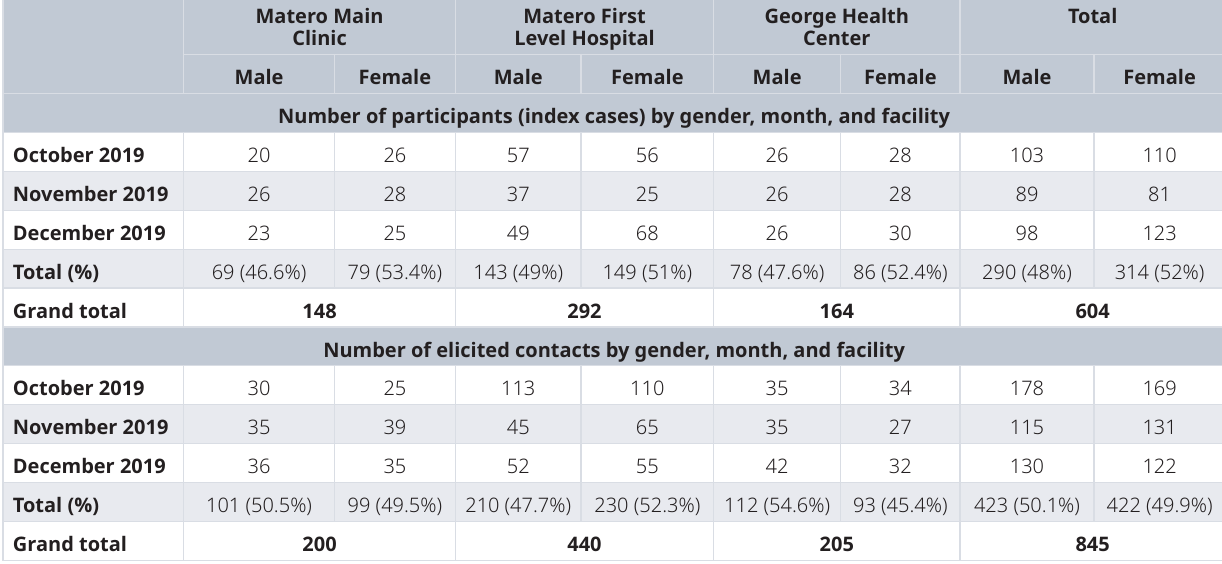
Table 1. Participants and their listed sexual contacts by gender, month, and